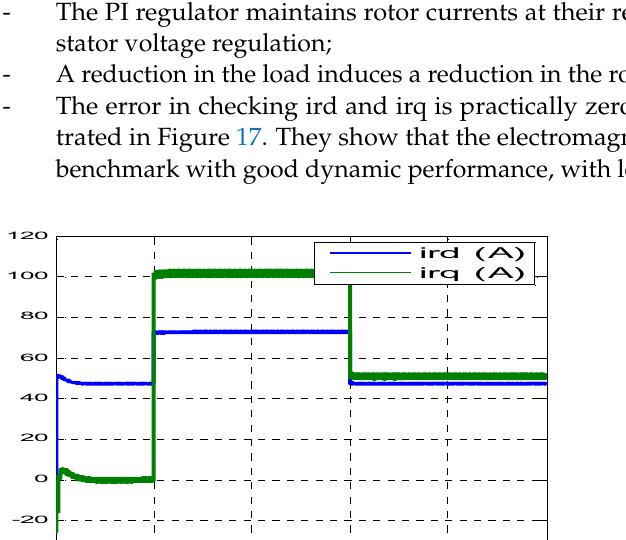
Figure 17. Electromagnetic torque. Moreover, the results in Figures 18 and 19 illustrate the simulation results of the sta- tor currents along the d and q axis and the three-phase stator currents generated by the doubly fed induction generator are proportional to the active power supplied. The wave- form of the current is almost sinusoidal for both stator currents, which means good quality of power supplied to the grid. Figures 20 and 21 illustrate the simulation results of the stator current voltages at the terminals of the doubly fed induction generator and the con- trol voltages of the rotor; the la tt er were obtained by a voltage inverter controlled by the genetic algorithm and which used the MLI technique. They show the waveform of the stator voltage and current. We can see that the stator voltage is equal to that of the grid, while the waveform of the current is related to that of the active power and the reactive power. The genetic algorithm regulator does not generate any overshoot, particularly at transient. For the other performances, they are almost similar to that of the PI regulator, which shows regulation by genetic algorithm control excellence through the e ff ective re- jection of the e ff ects of the disturbances from which the authorities completely trace their references.